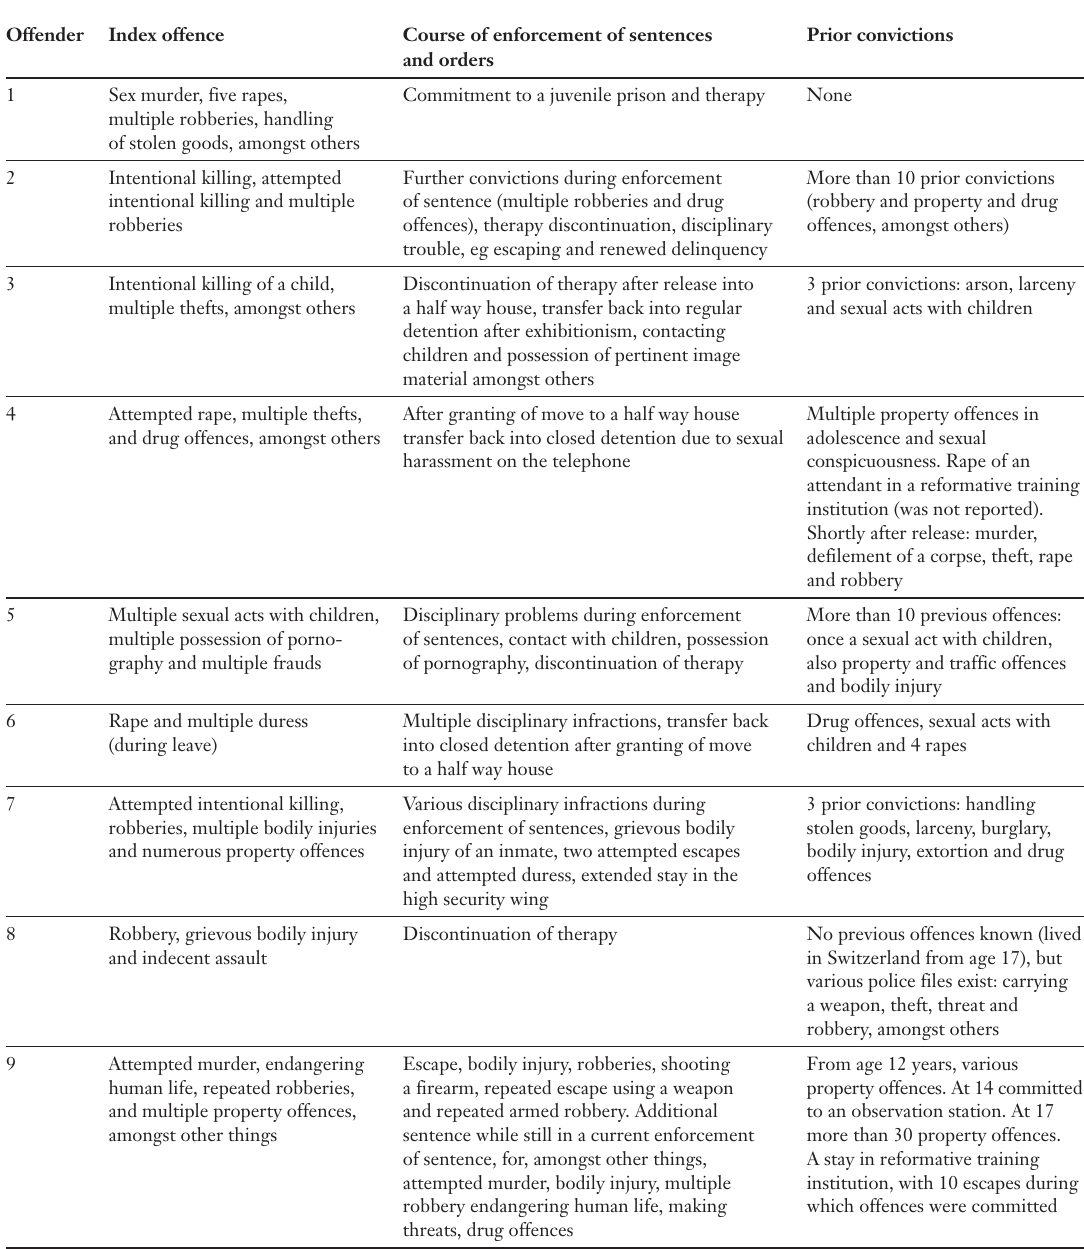
Description of the